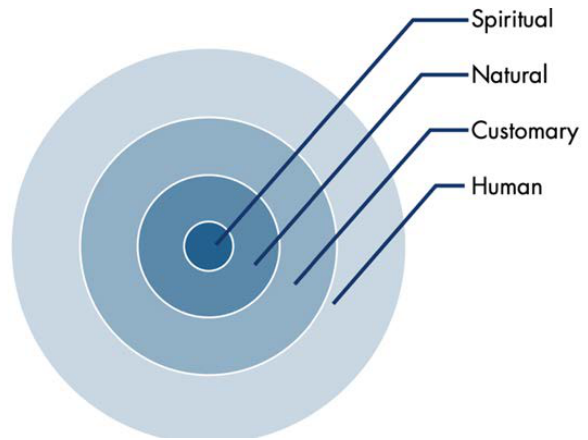
Figure 1. Sources of Anishinaabe Inaakonigewin (law) [19]. Copyright 2018 Centre for Institutional Governance